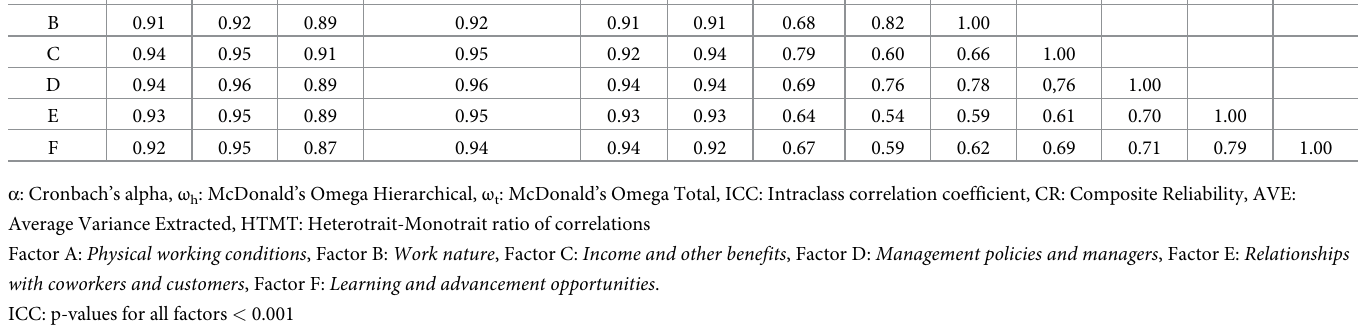
Table 4. Main indicators used to assess the reliability and validity of the VIJS. Factor